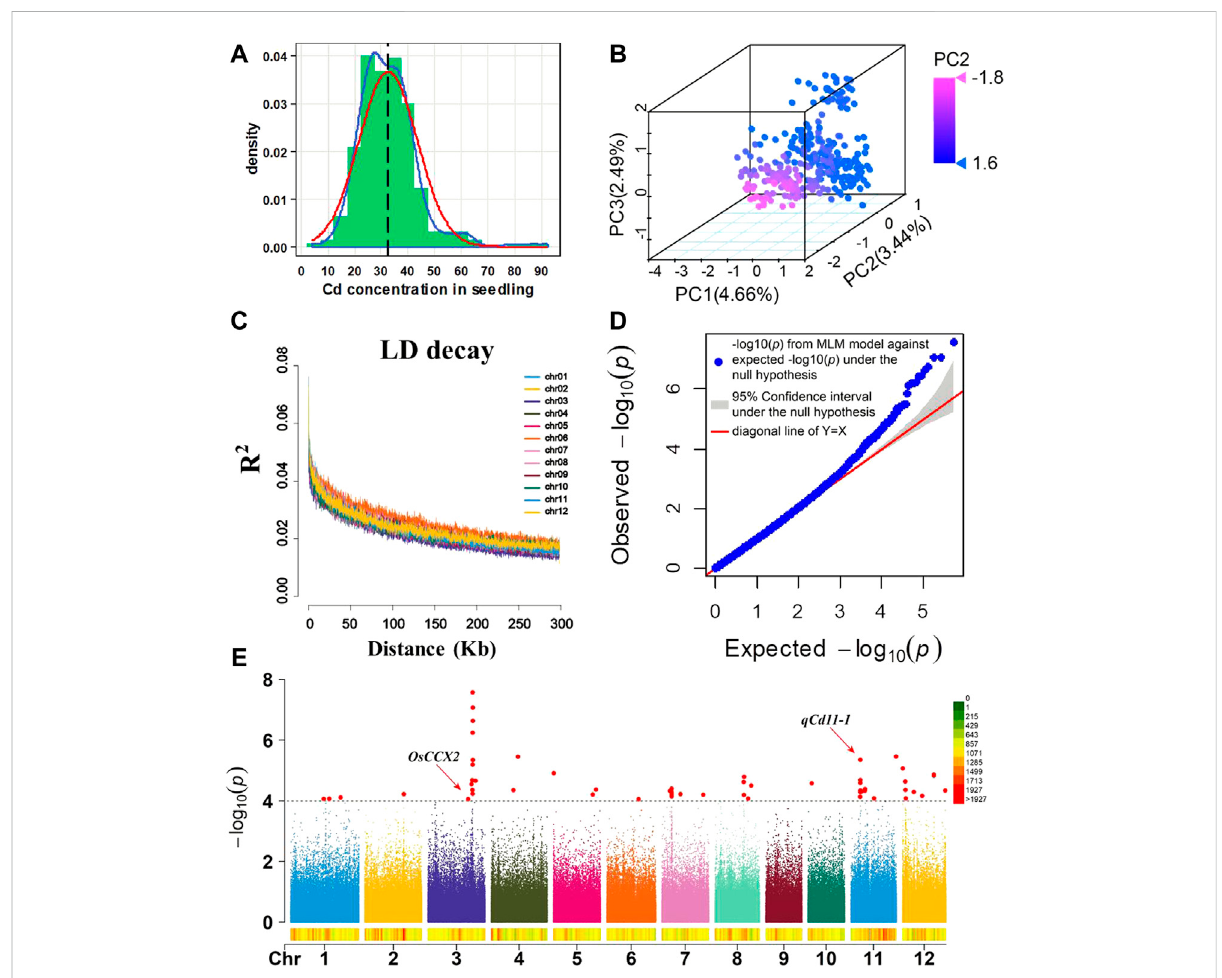
FIGURE 1 (A) Frequency distributionoftheCd concentrationin 315rice accessions.Blue line: trendline, red line: normal distributionline,black line: mean of the Cd concentration, and mean = 32.58. (B) Principal component analysis on 399,200 SNPs of 315 rice accessions. PC1, PC2, and PC3 represent the three principal components of the population. The color from red to blue represents the PC2 value. (C) Genome-wide average LD decay estimatedin315riceaccessions. (D) QQplotfortheGWASoftheCdconcentrationintheshoot. y -axis:observed-log 10 ( p )and x -axis:expected -log 10 ( p ) under the assumption that p follows a uniform[0,1] distribution. The red lines and gray region show the 95% con fi dence interval for the QQ plot under the null hypothesis of no association between the SNP and the trait. (E) Manhattan plots of the GWAS of shoot Cd accumulation in 12chromosomes.Theredarrowrepresentsthelociclosetopreviousgenes.The graydashlinerepresentsthesigni fi cantthreshold( p =1.00 ×10 – 4